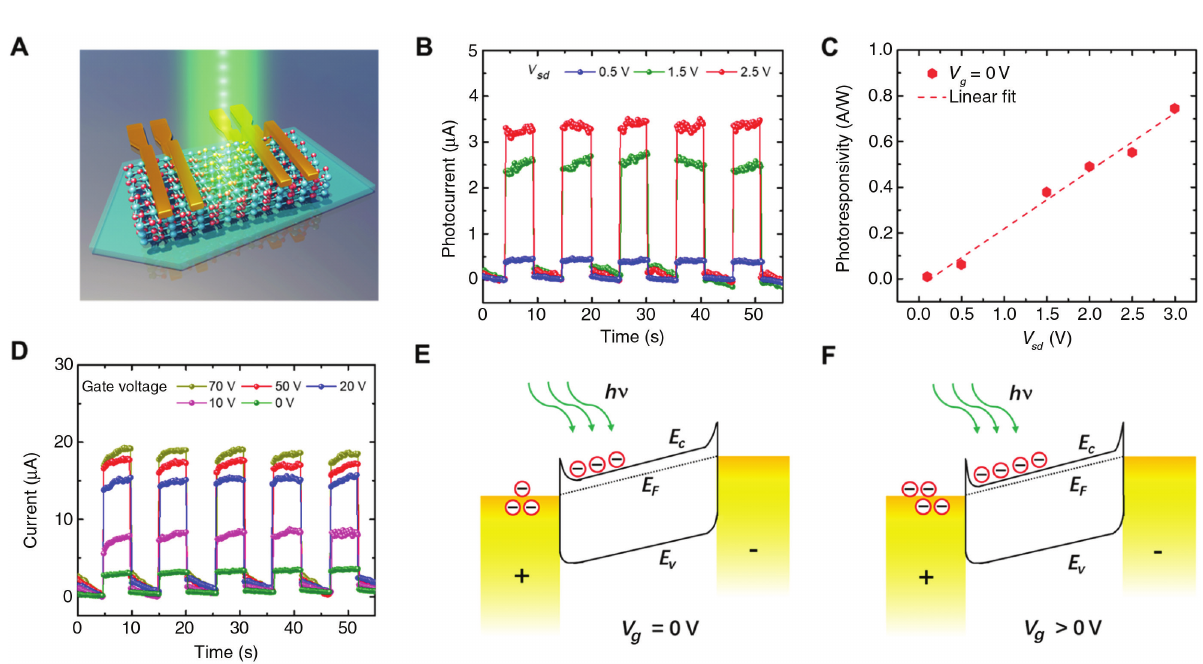
flake. Figure 2: Optoelectronic characterization of few-layered PdSe 2 (A) Three-dimensional illustration of the device structure used to measure photo current. (B) Time-dependent photocurrent under different bias voltage V . (C) Photoresponsivity as function of V . (D) Time dependence of photocurrent measured at different gate voltages. (E and F) sd sd Qualitative energy band diagrams of PdSe device through gating 2